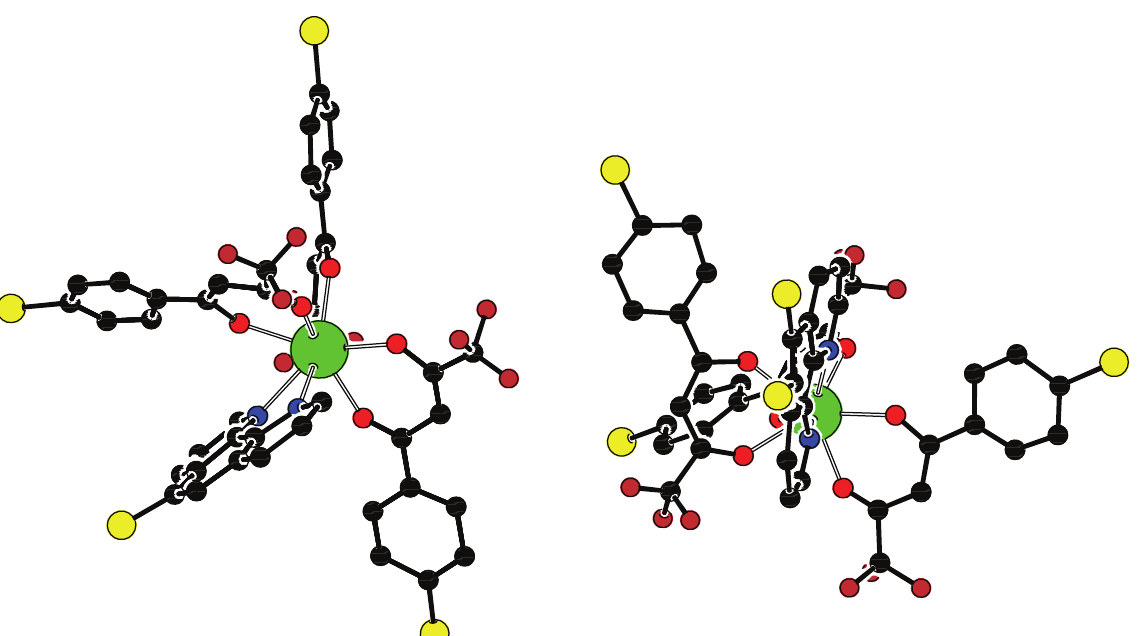
Figure 2: Structural diagram of complex 1, tris(1,4-chlorophenyl-4,4,4-trifluoro-1,3-butanedionate) mono(5-chloro-1,10-phenanthroline) europium(III). H atoms have been omitted for clarity